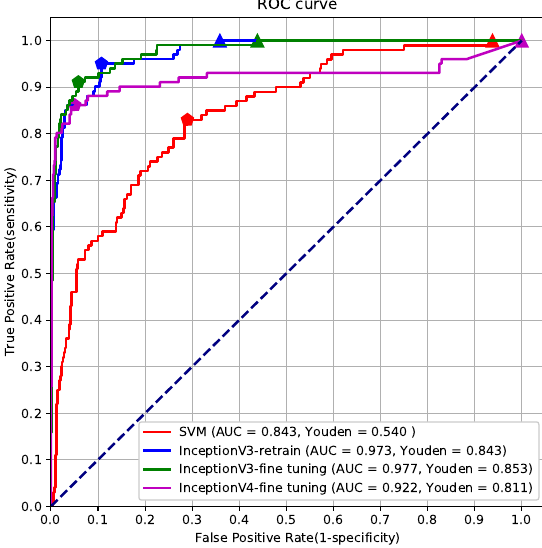
Figure 7. ROC of the classifier. (1) in the case of a 100% recall. The threshold points of the classifier are marked with triangles, indicating that all images with foreign objects can be screened when the images are classified by the threshold corresponding to the points. The abscissa value corresponding to the threshold point is the misclassification rate, which means that the triangle mark closer to the left side corresponds to the lower classification error rate, and the performance of the algorithm is better. (2) We calculate the optimal classification threshold by using the Yoden index. The optimal threshold point of the classifier is marked by a pentagon, which means that only a part of the foreign object image can be selected when the image is classified by the threshold value of the mark point, and the classification error rate is also decreased. (3) InceptionV3-fine-tuning has AUC = 0.977 as the maximum value and SVM has AUC = 0.843 as the minimum